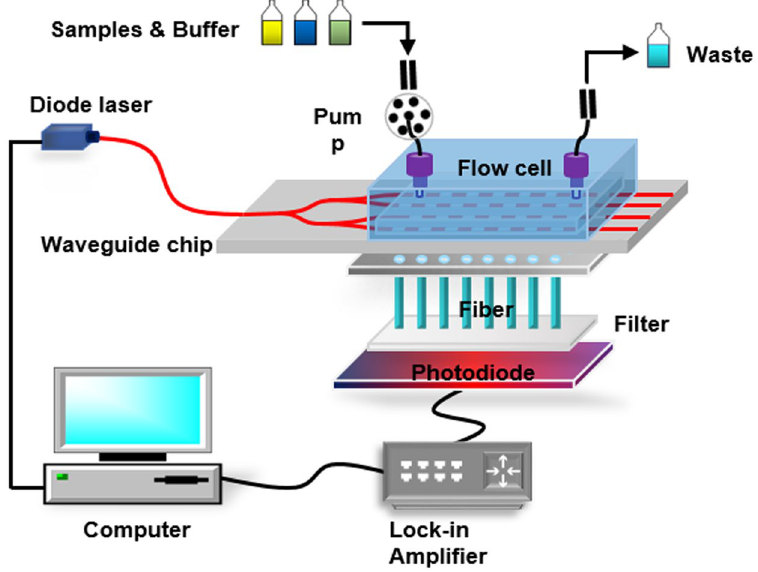
Figure 3. Schematic diagram of the integrated optical fluorescence multi-channel